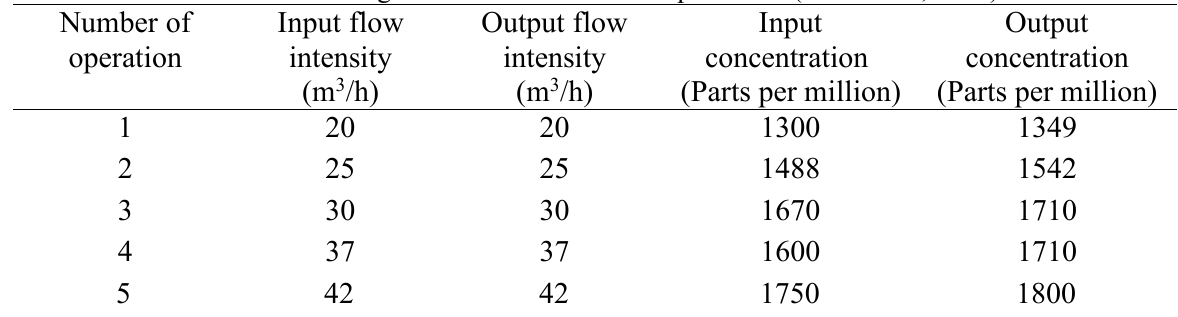
Table 3. Restriction data of cooling tower for dissolved solid pollutants (Shafikhani,